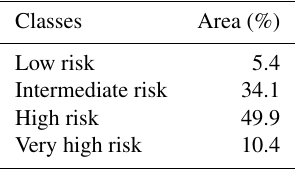
Figure 9. Landslide susceptibility map (Abbottabad–Chilas): (a) Ji- jal section (area in box “X” is shown in Fig. 15), (b) Dassu section and (c) Sazin section. Table 7. Area of susceptibility classes.